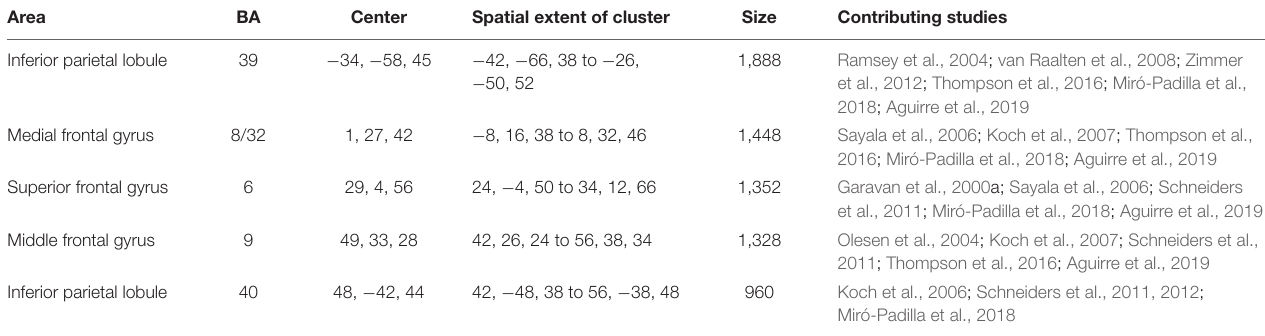
TABLE 3 | Clusters exhibiting reduced brain activation in relation to working memory